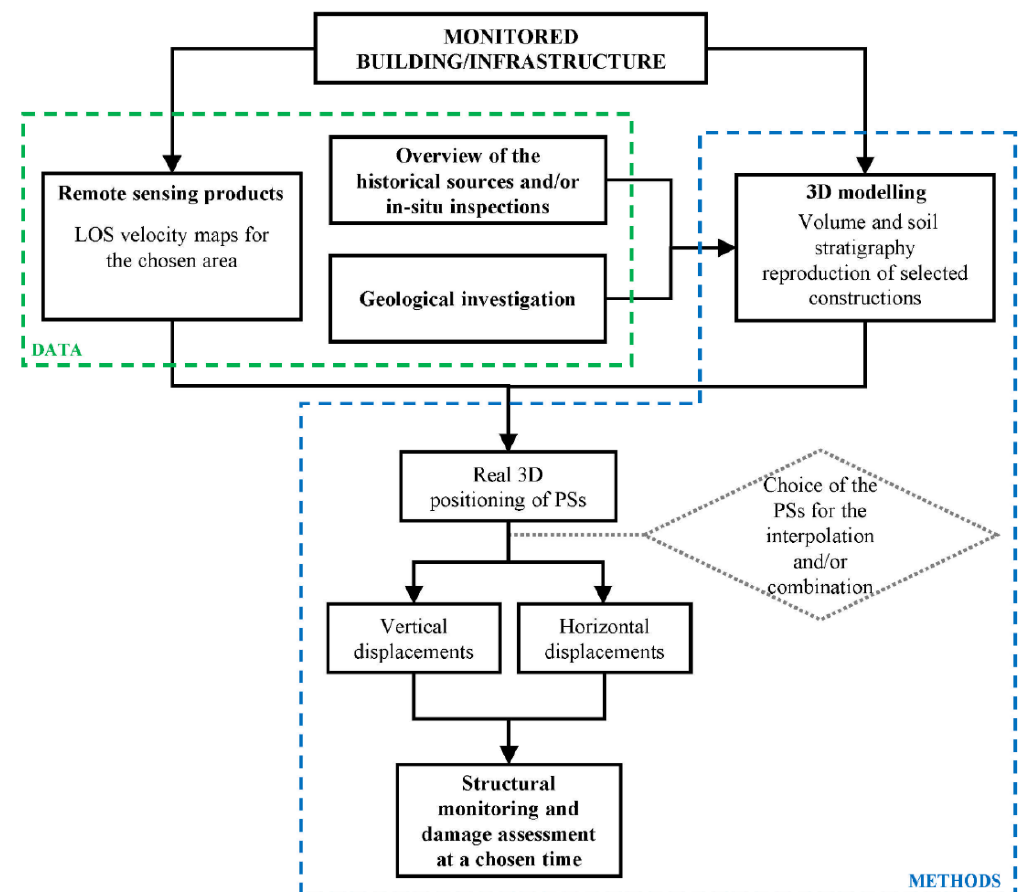
Figure 1. Flowchart of the presented methodology.